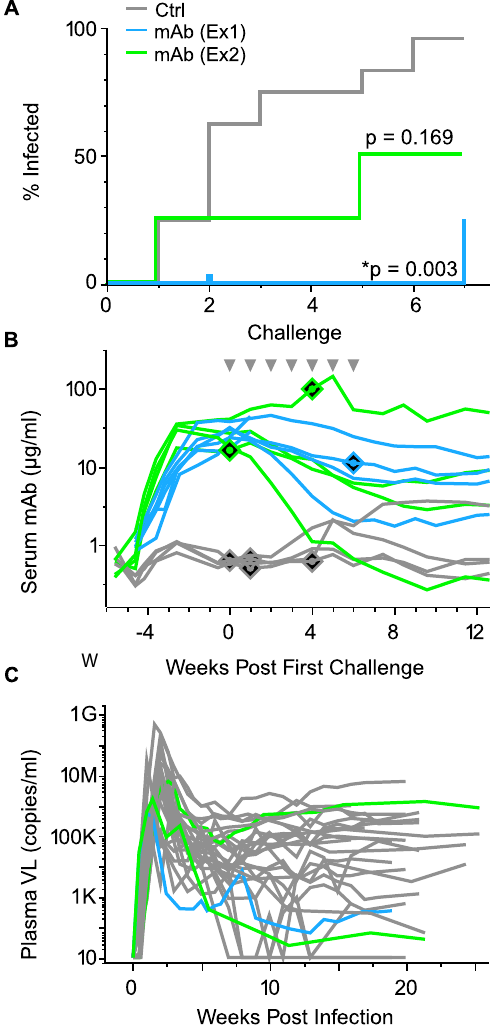
Fig 7. Vectored immunoprophylaxis mediates a protective effect against limiting dose SIVsmE660 swarm challenge in rhesus macaques. (A) Limiting dose intrarectal challenges were administered weekly as denoted in the Kaplan-Meier curve on the x-axis to animals receiving mAb (ITS01+ITS06.02) via AAV in our initial (blue, n = 6) and repeat (green, n = 4) groups or no mAb controls (gray, n = 24). Two animals were censored from analysis after challenge 2 due to false positive viral loads (vertical ticks) (B) Serum anti-SIV env transgene mAb was quantified and plotted (y-axis) versus time (x-axis) for mAb pretreated animals and four contemporaneous control animals. Diamonds indicate timepoint of infection corresponding to animals’ expression level line. Challenges at AID 0.33 are denoted as grey downward facing triangles above. (C) Plasma viral loads (y-axis) are plotted versus time post infection